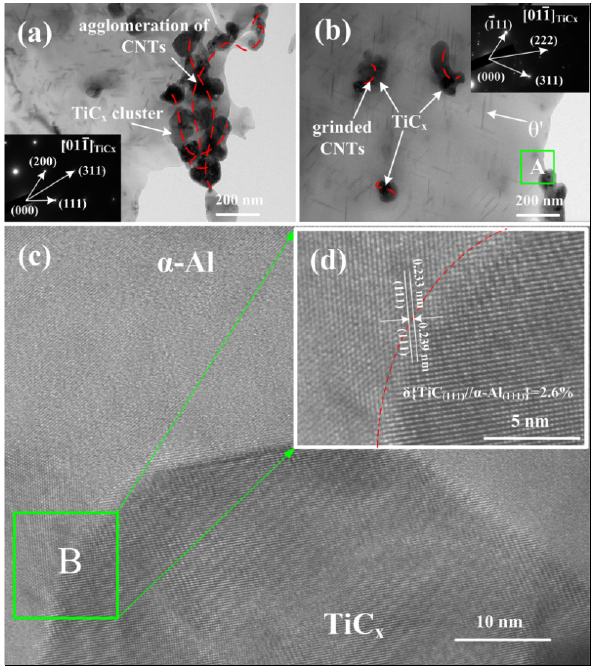
Figure 6. ( a – b ) TEM images of as-extruded 9 vol% TiC x /2009Al composites prepared by using ( a – b ) untreated CNTs and 2 h-milled CNTs as the carbon source, insert: selected-area electron diffraction (SAED) pattern of TiC x particles; ( c ) HRTEM image of the area A in Figure 6b; ( d ) the magnification of HRTEM images of areas B.